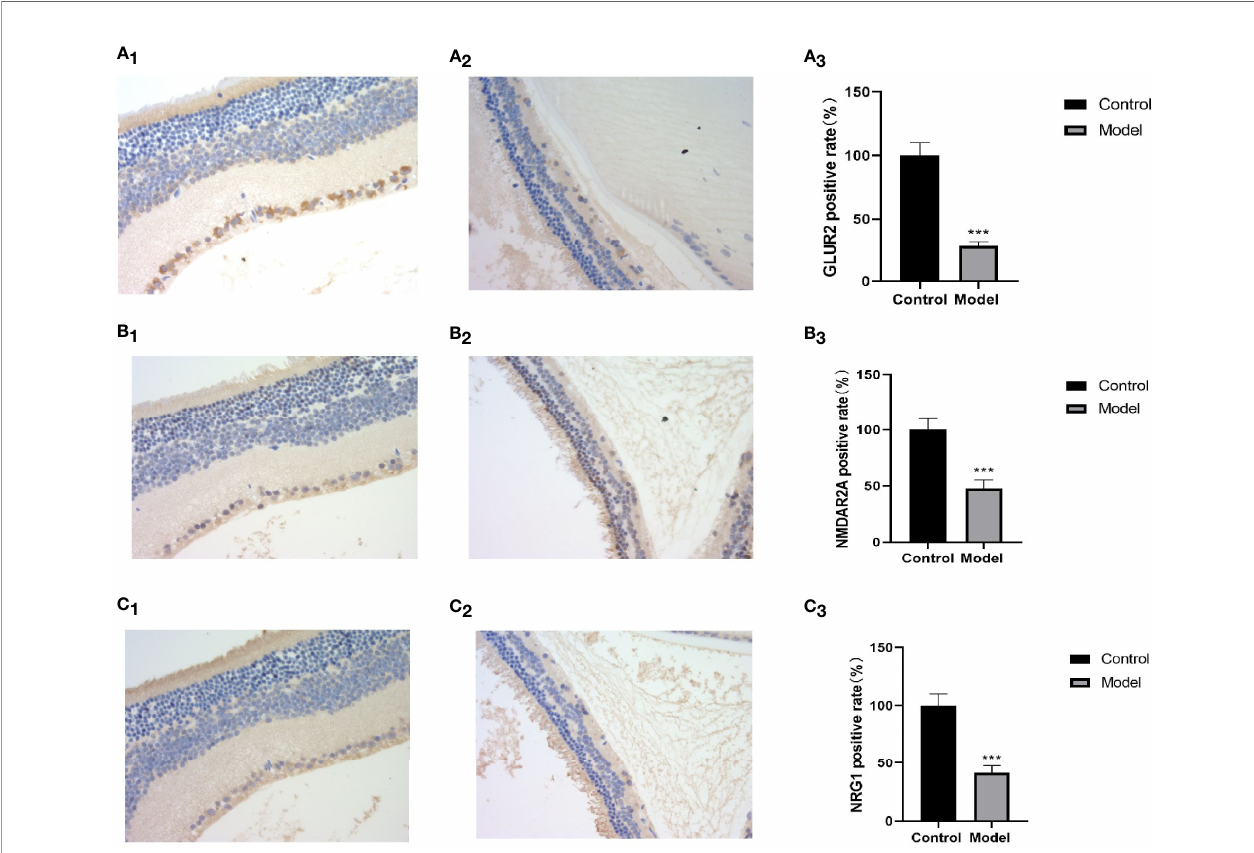
FIGURE 8 | Retinal HE and immunohistochemical images and positive rate calculation. (A1) The immunohistochemical image of GLUR2 in normal ICR mice. (A2) The immunohistochemical image of GLUR2 in MSG mice. (A3) The calculated result of the GLUR2-positive rate. (B1) The immunohistochemical image of NMDAR2A of normal ICR mice. (B2) The immunohistochemical image of NMDAR2A of MSG mice. (B3) The calculated result of the positive rate of NMDAR2A. (C1) The immunohistochemical image of NRG1 in normal ICR mice. (C2) The immunohistochemical image of NRG1 in MSG mice. (C3) The calculated result of the positive rate of NRG1. All HE and immunohistochemical images were taken at ×40. Vs. control group: *** p <